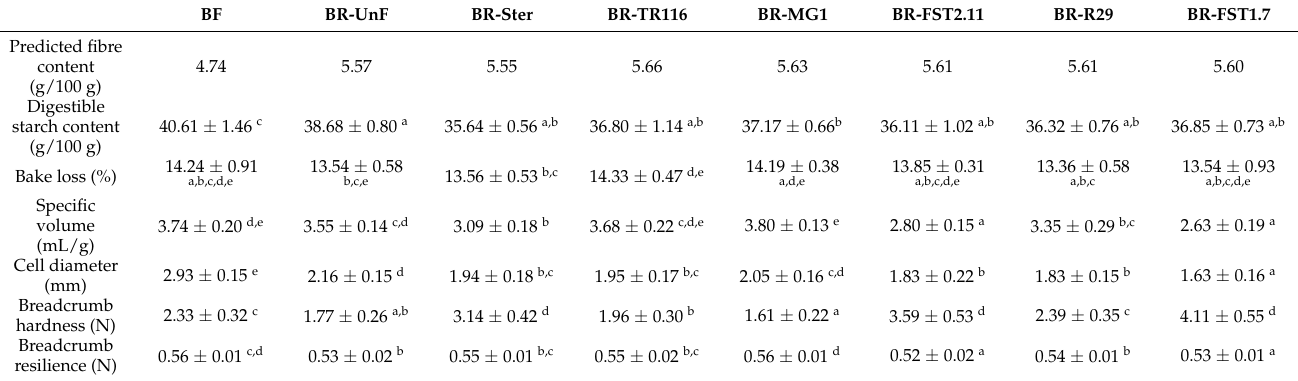
Table 5. Bread quality characteristics with the inclusion of barley rootlets and novel fermented barley rootlet ingredients (5% inclusion, based on flour). BF represents a control recipe using only baker’s flour. BR-UnF and BR-Ster denote control recipes using unfermented barley rootlets and sterile, freeze-dried barley rootlets, respectively. BR-TR116, BR-MG1, BR-FST2.11, BR-R29, and BR-FST1.7 illustrate fermented rootlet recipes with ingredients fermented using L. citreum TR116, W. cibaria MG1, L. amylovorus FST2.11, L. reuteri R29, and L. plantarum FST1.7, respectively. Results are represented as means ± standard deviation. No significant differences were found between samples that shared the same subscript letter in the same row ( p <